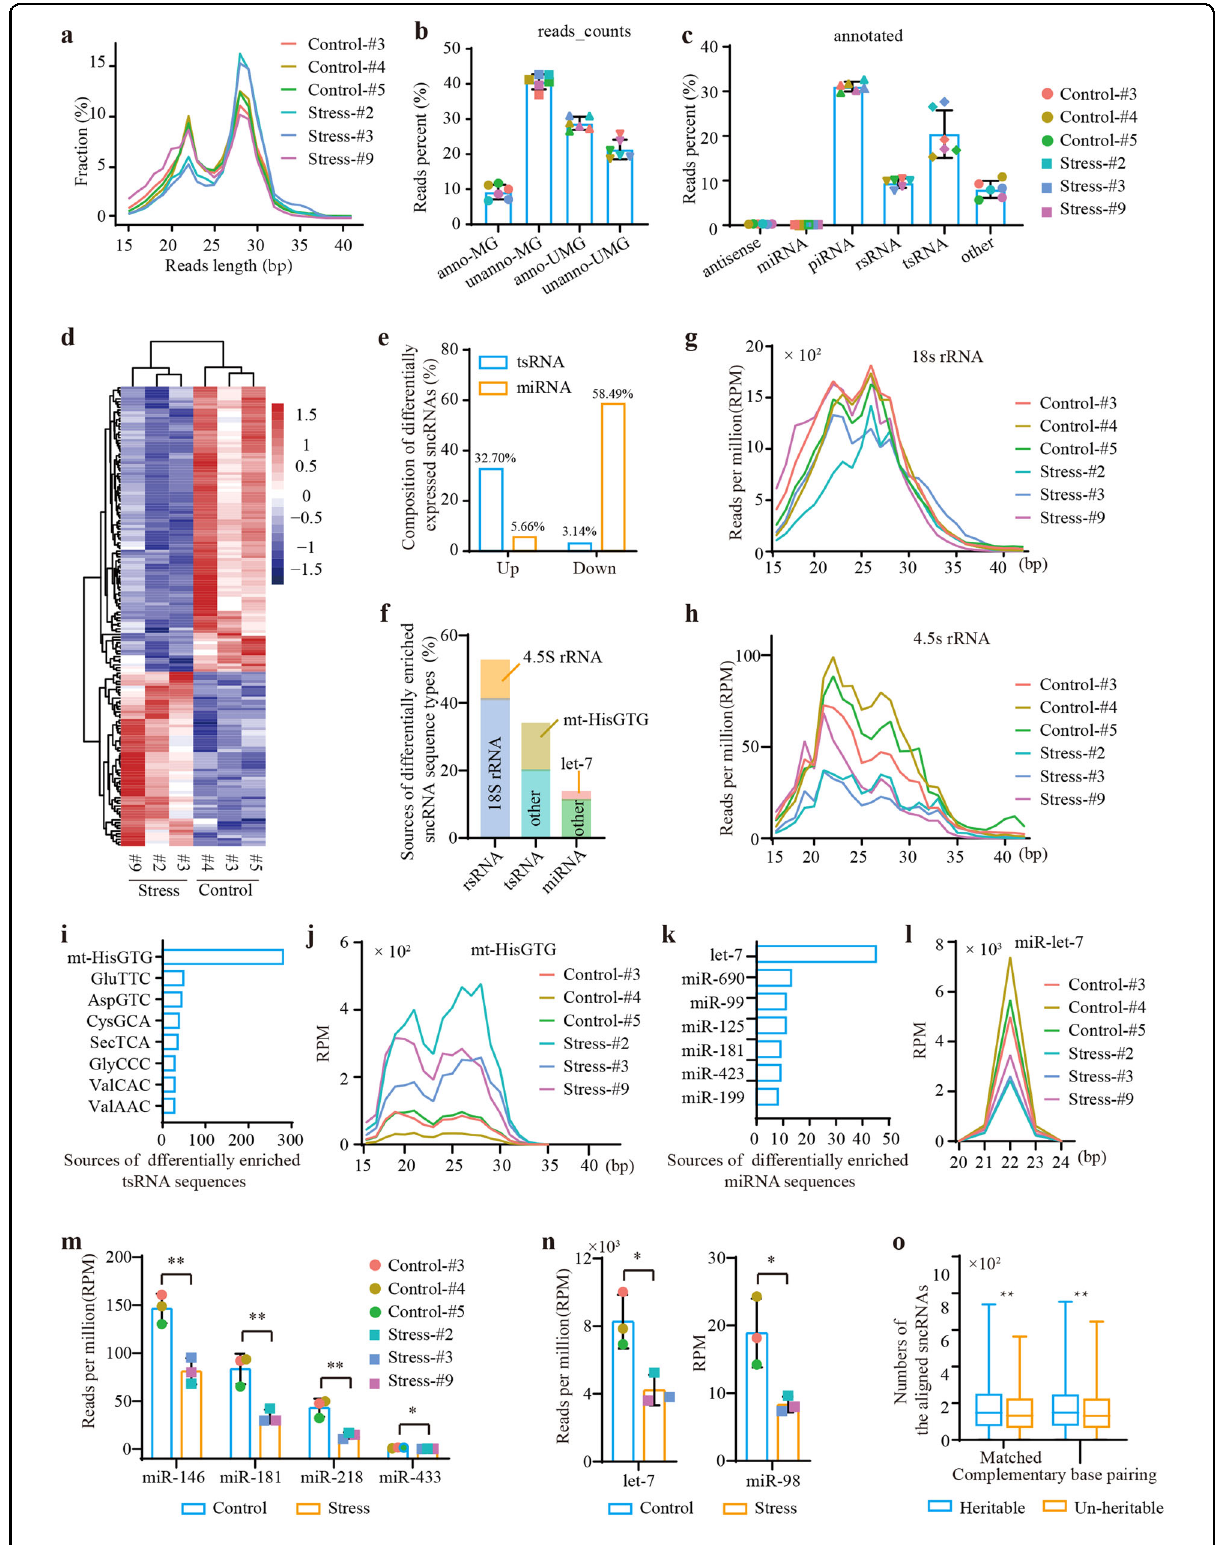
Fig. 6 (See legend on next